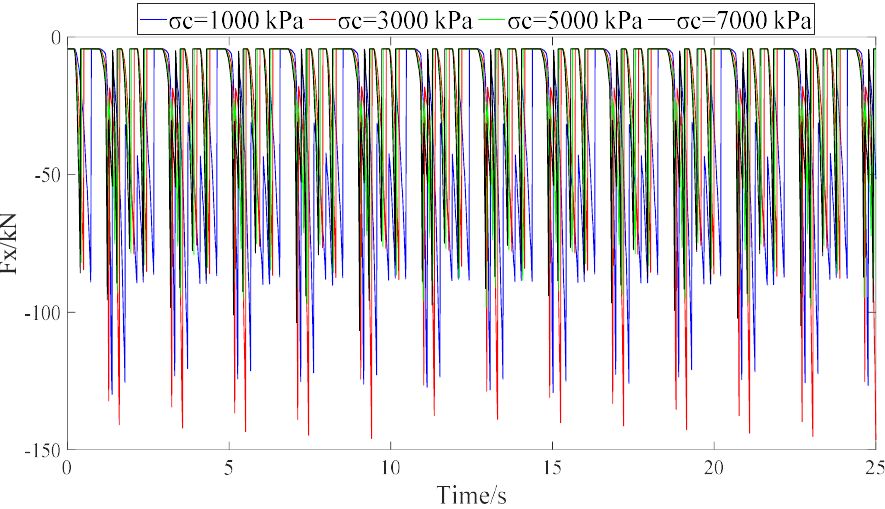
Figure 22. Time history curves of total ice force under different crushing strength ( σ c ).